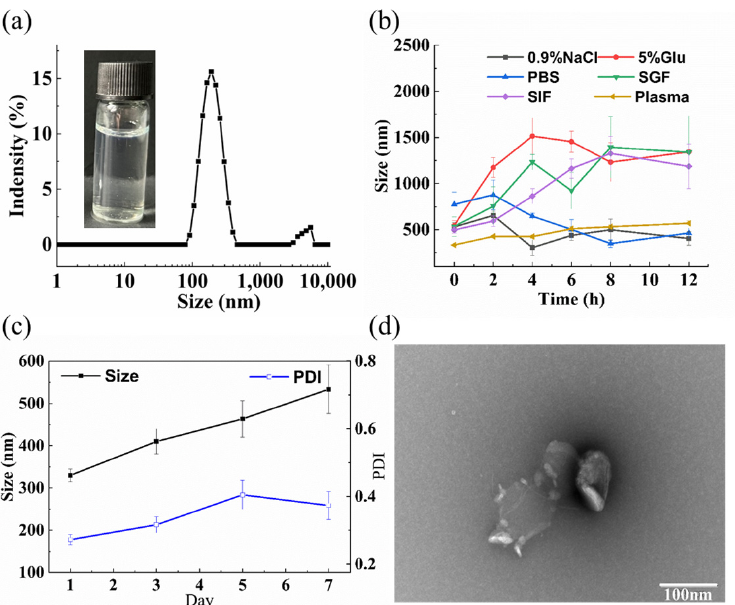
Figure 4. The actual photo and the particle size distribution of TH aggregates ( a ). The particle size change of TH aggregates in various physiological media ( b ). The particle size and PDI change of TH aggregates during the 7 days shelf storage ( c ). Transmission electron microscopy image of TH ag- gregates ( d